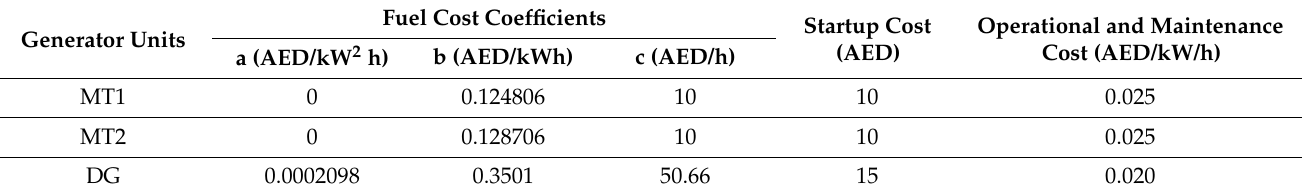
Table 3. Cost coefficients of dispatchable